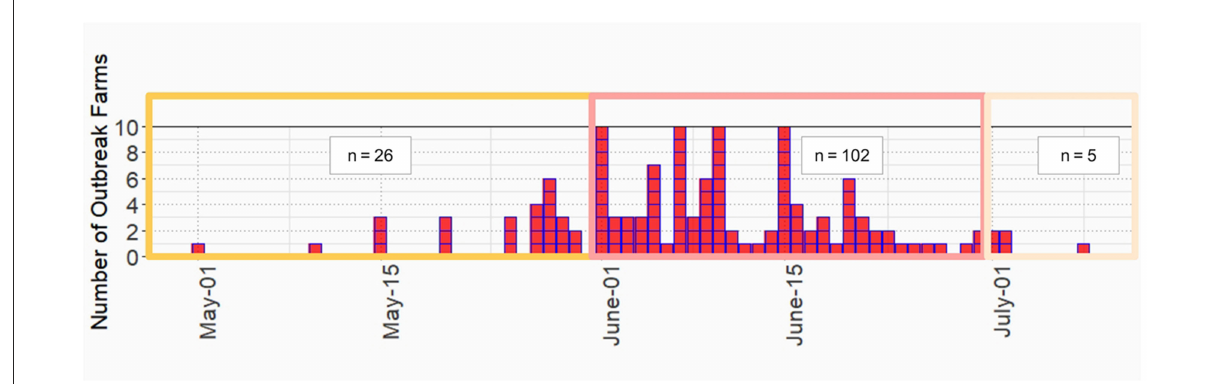
FIGURE2 Epidemic curve of lumpy skin disease outbreak in dairy farms, Khon Kean province, Thailand.